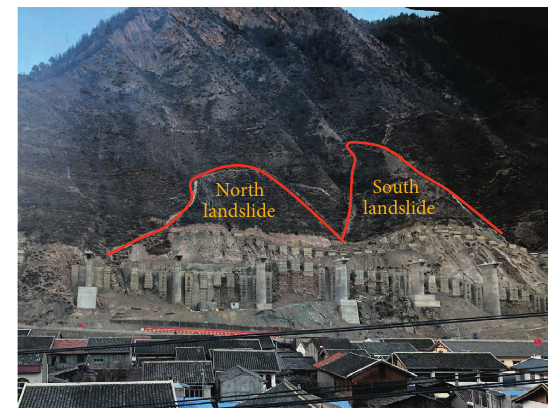
Figure 3: The illustration of the landslide body.